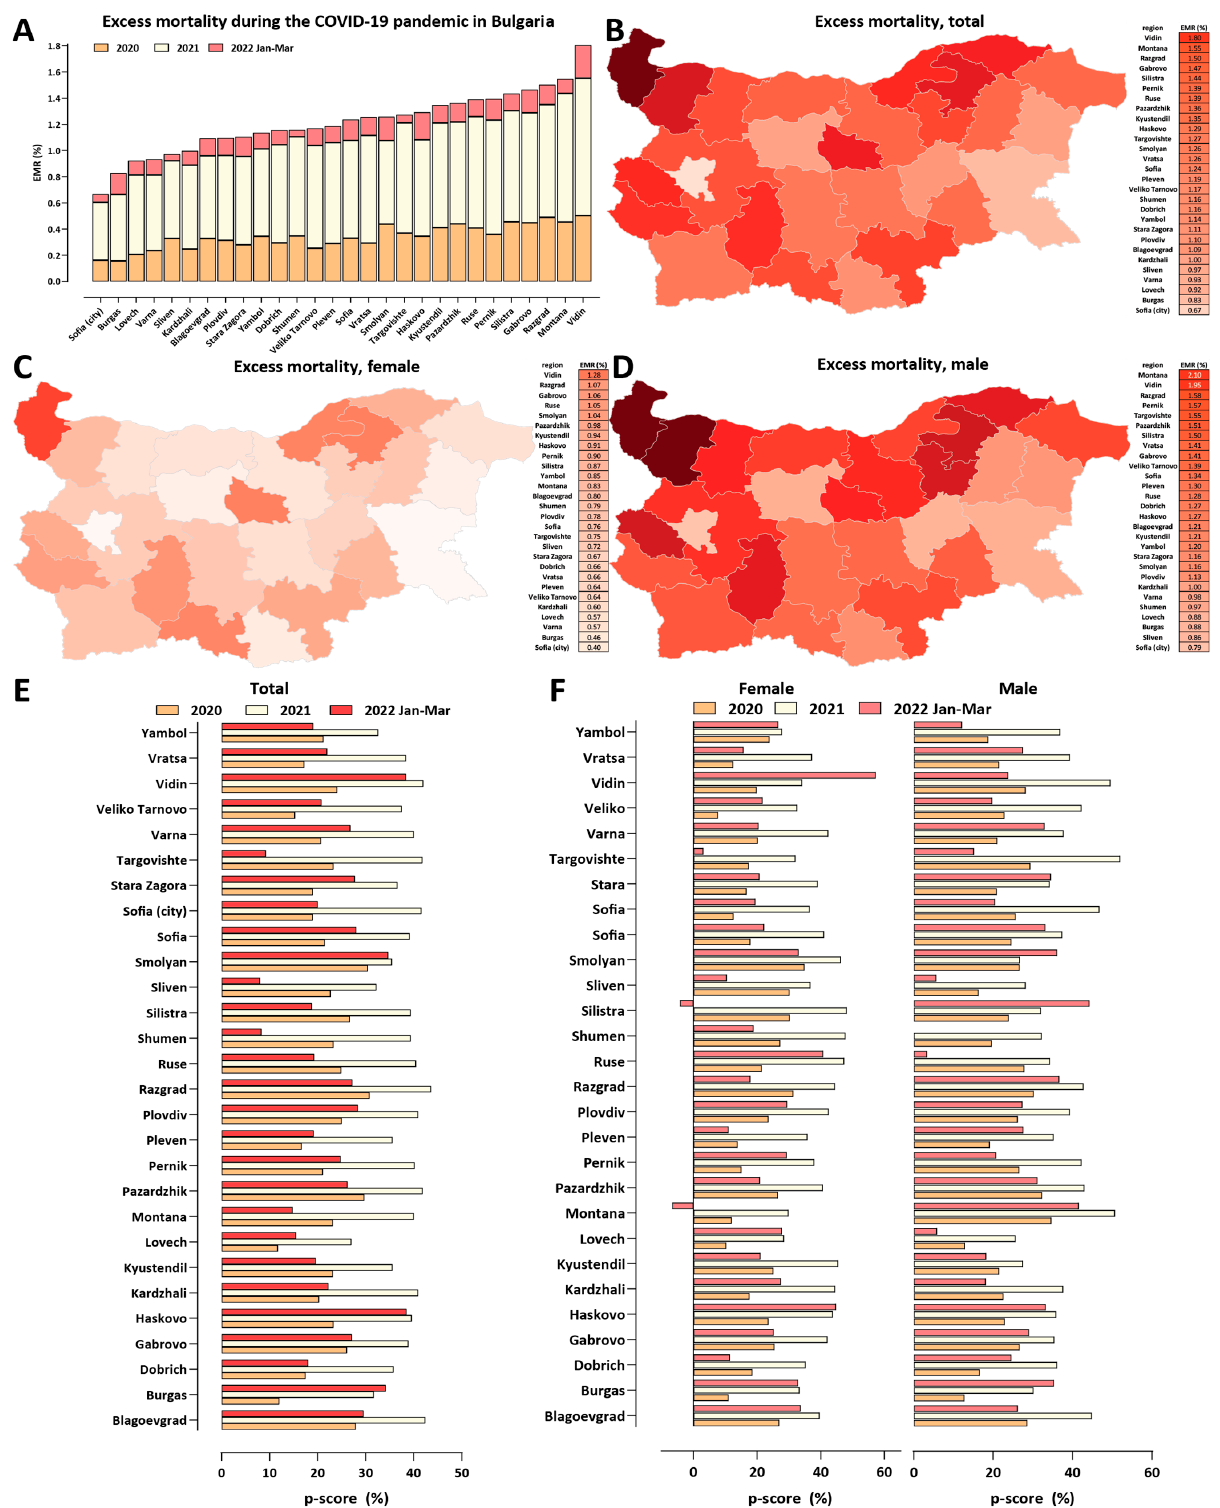
Figure 4. Regional excess mortality patterns in Bulgaria during the COVID-19 pandemic (up to the end of March 2022) . ( A ) Excess and official mortality by region and year; ( B ) excess mortality by region, in total; ( C ) excess mortality by region, for males; ( D ) Bulgaria, excess mortality by region, for females; ( E ) excess mortality (P-scores), per year; ( F ) excess mortality (P-scores), for males and females, per year.